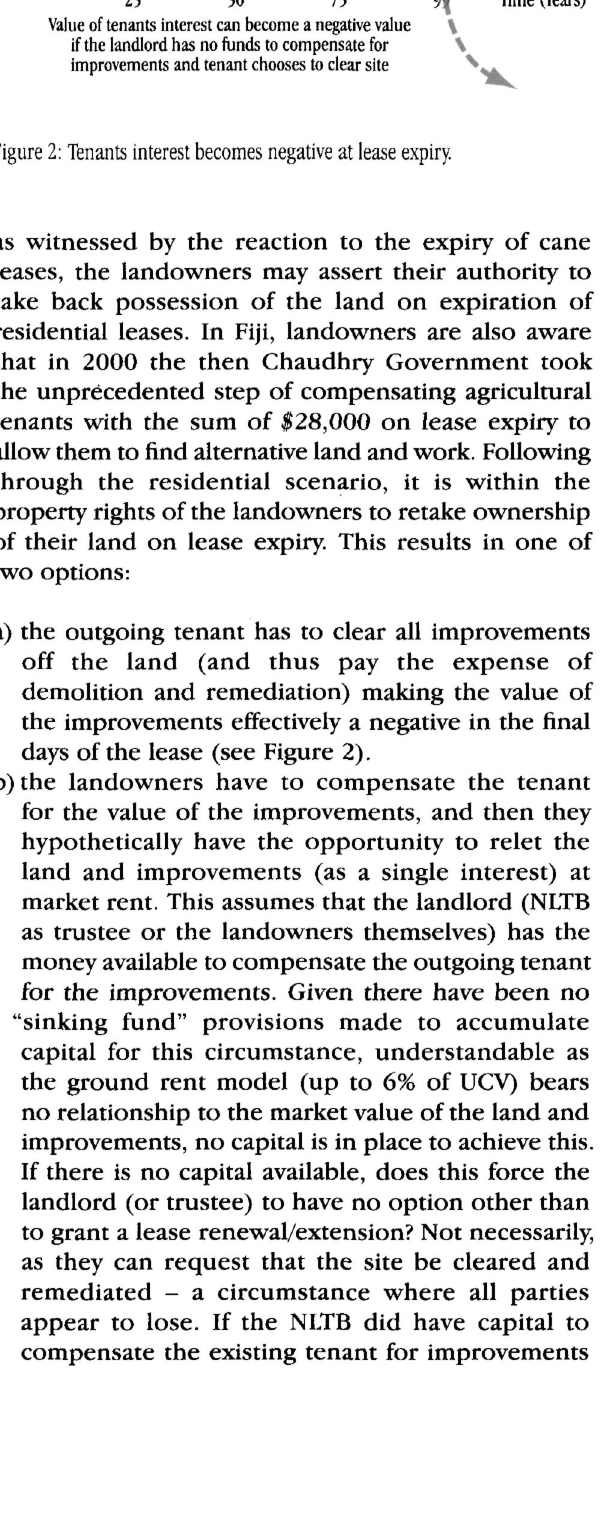
Figure 3: Marriage value of landlord and tenants interest on lease